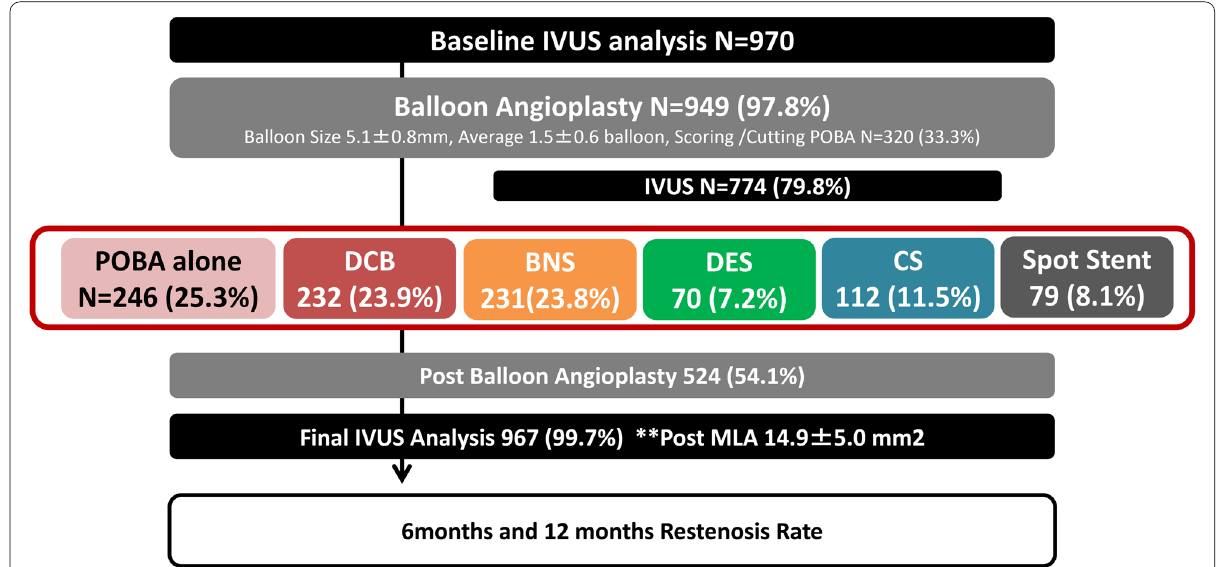
Fig. 2 The scheme of study. Patient enrollment numbers: consented (970), plain old balloon angioplasty: POBA (246), drug-coated balloon: DCB (232), bare nitinol stent: BNS (231), drug-eluting stent: DES (70), covered stent: CS (112), and spot stent (79). IVUS: intravascular ultrasound, MLA: Minimum Lumen